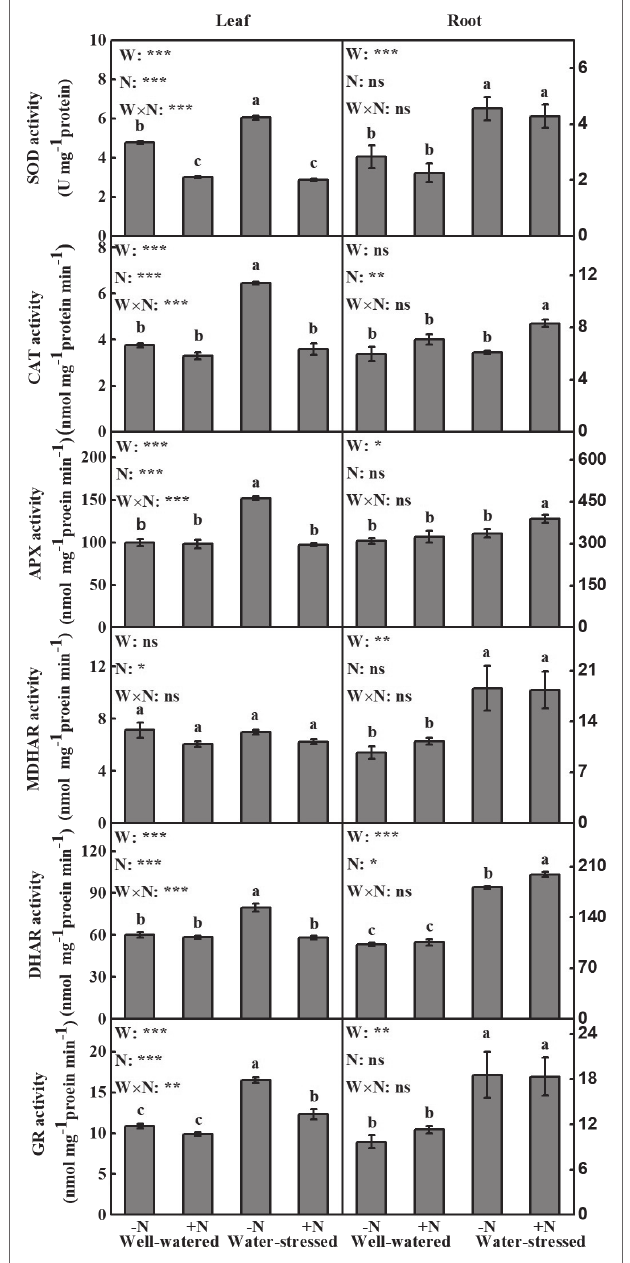
FIGURE 3 | Antioxidant enzymes of Fargesia denudata leaves and roots for N non-deposition ( − N) and N deposition (+N) treatments with and without drought stress. F W , water effect; F N , N deposition effect; and F W × F N , interactive effect of water and N deposition. SOD, superoxide dismutase; CAT, catalase; APX, ascorbate peroxidase; MDHAR, monodehydroascorbate reductase; DHAR, dehydroascorbate reductase; GR, glutathione reductase. Values with different letters are significantly different at p < 0.05. Vertical bars show ± S.E. Significant levels: *** p < 0.001; ** p < 0.01; * p < 0.05; ns (non-significant) p > 0.05.